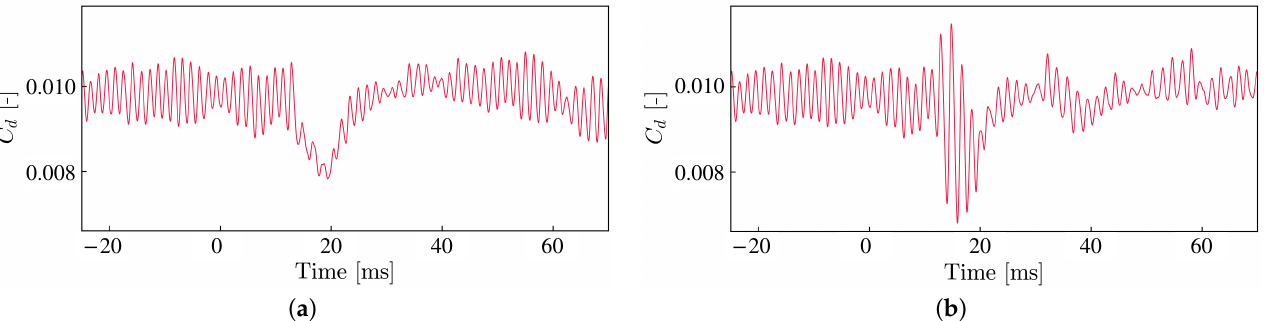
Figure 18. Time history of the drag coefficient C d . ( a ) Narrow; ( b ) Wide.